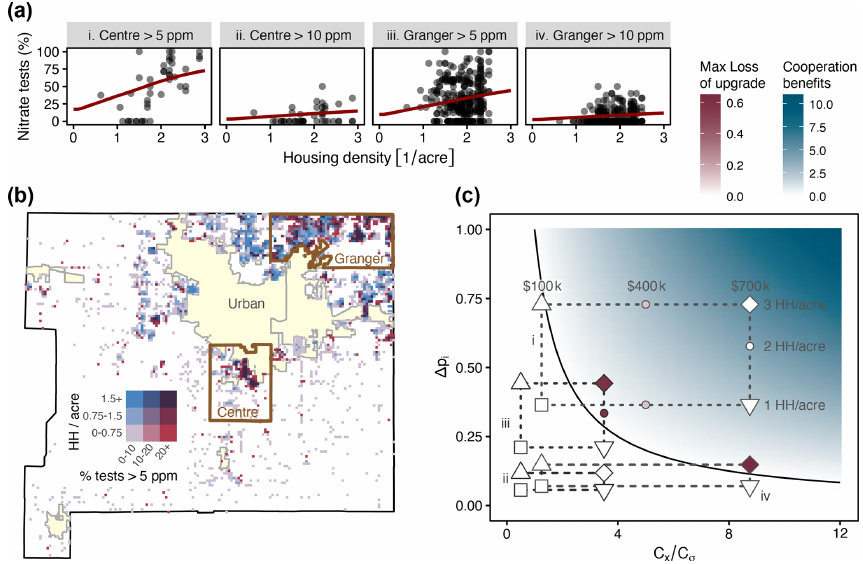
Figure 7. St. Joseph case study. (a) Percent of nitrate tests exceeding a given threshold versus the housing density for Centre Township and Granger CDP. (b) Map of St. Joseph County, with colors indicating the housing density and percent of nitrates tests exceeding 5ppm in 16-acre (0.0647km 2 ) pixels. (c) Social dilemmas based on housing price and housing density (shown) and costs of contamination and septic upgrades (not shown; see the text). Cooperation benefits, (cid:49)p i C x /C σ − 1, are shown as background shading (in blue), and the maximum loss of upgrading, 1 − (cid:49)p ii C x /C σ , is shown as the fill color of the example points (in red). Note that both are defined in the same way as in Fig.